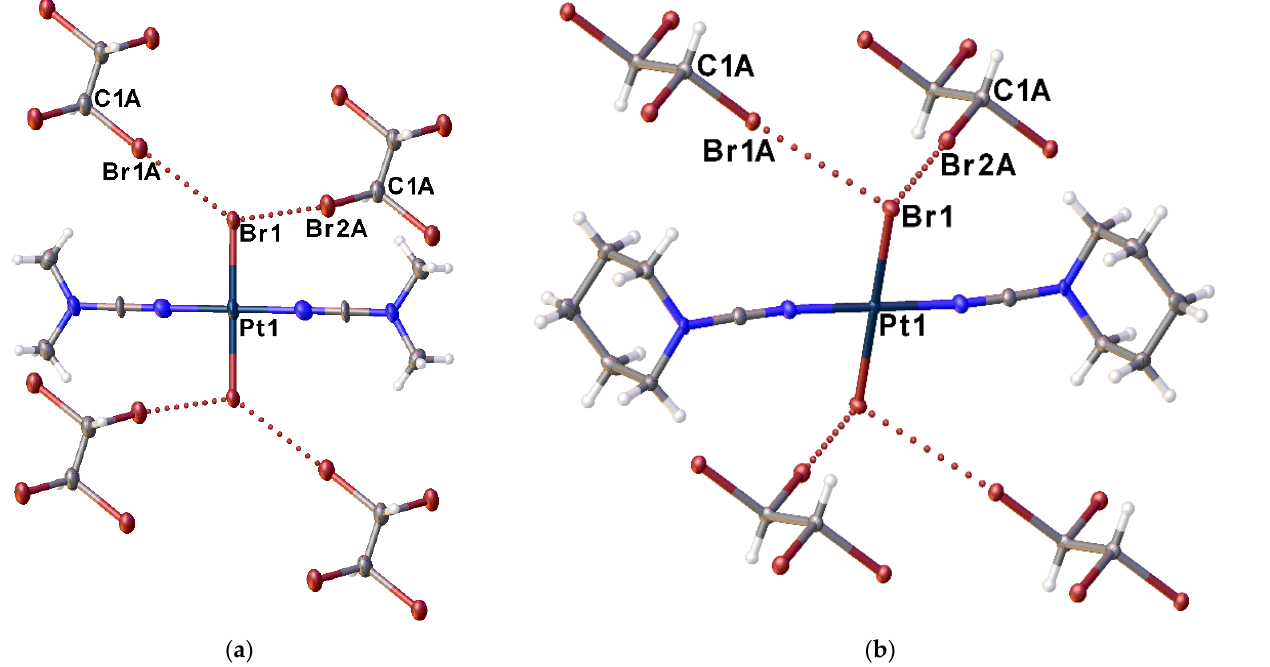
Figure 4. ( a ) the environment of 1 in 1 · tbe , halogen bonds assigned by dotted lines. Hereinafter thermal ellipsoids are shown with 50% probability; ( b ) The environment of 2 in 2 · tbe , halogen bonds assigned by dotted lines.